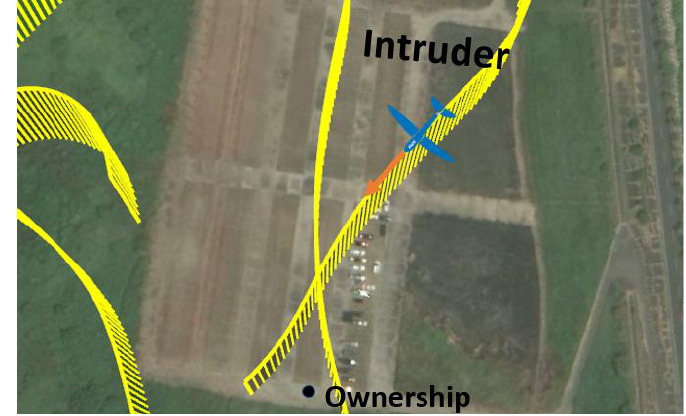
Figure 23. Flight path of the intruder in Experiment 2.